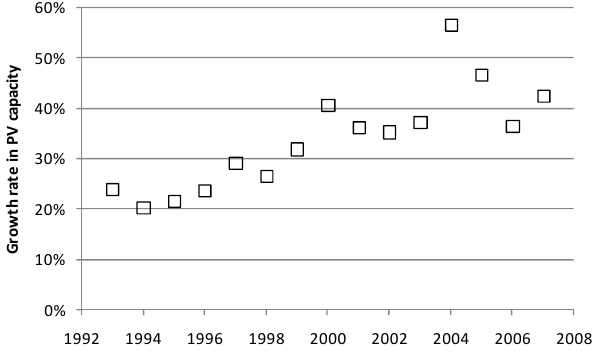
Figure 61. Annual growth in PV installed capacity (after